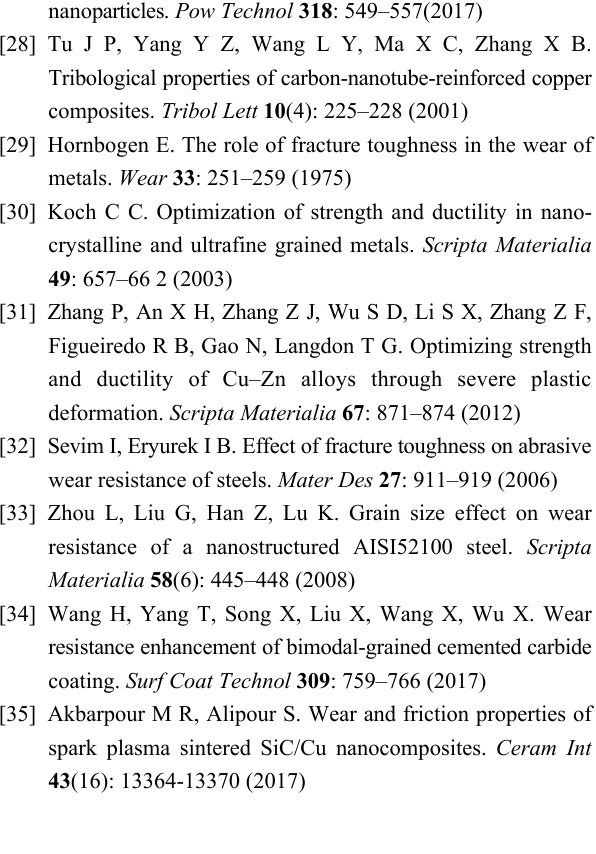
Figueiredo R B, Gao N, Langdon T G. Optimizing